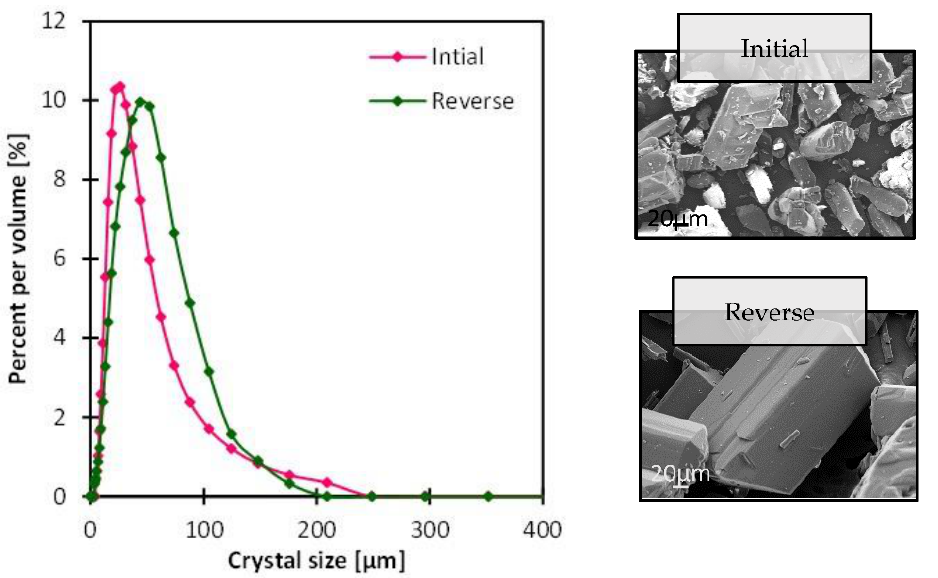
Figure 9. SEM images of crystals recovered from the bulk solution after MAAC operation and the corresponding crystal size distribution, with the variation of the gravity resistance.